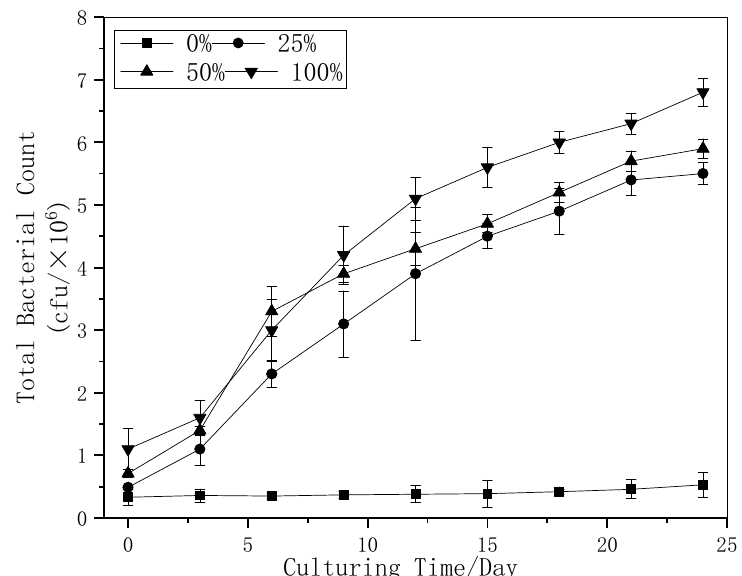
Figure 8. Variation curve of total bacteria in long-term culture experiments under different CBM produced water concentrations. Error bars indicate standard errors (n =